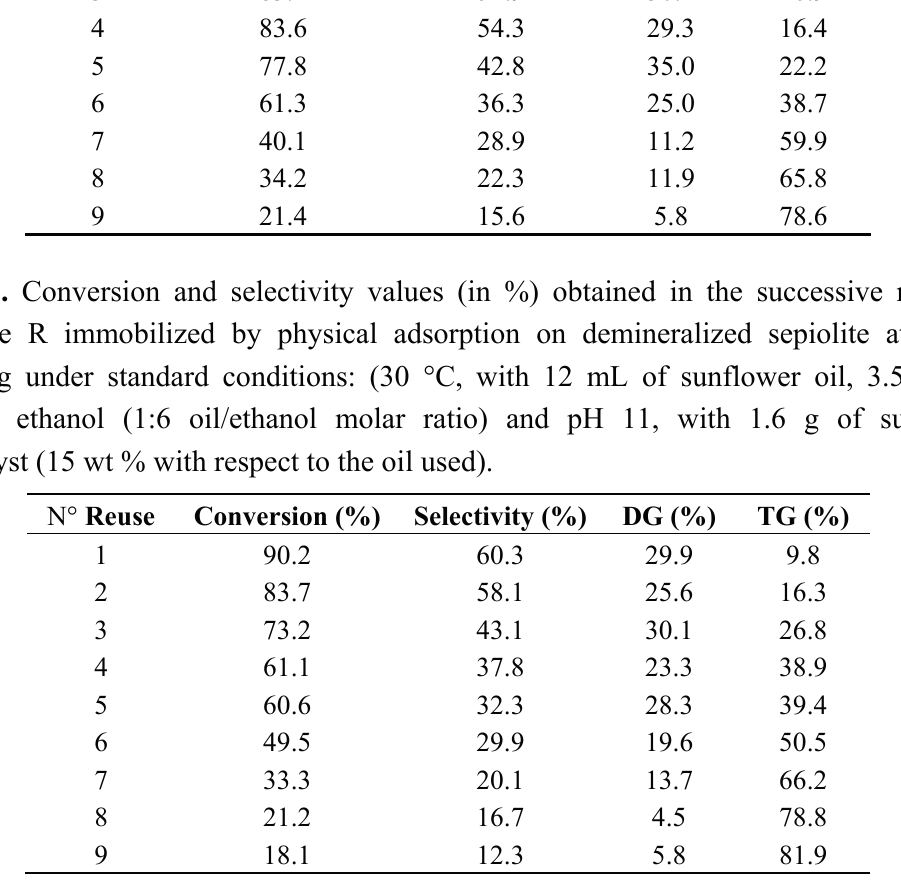
Figure 4. Residual activity of reuses of the two selected immobilization systems of Biolipase R on Sepiolite as support: ( ■ ) covalent immobilization obtained by using p-hydroxybenzaldehyde as linker ( ▲ ) physical retention of lipase by using demineralized sepiolite obtained after acid